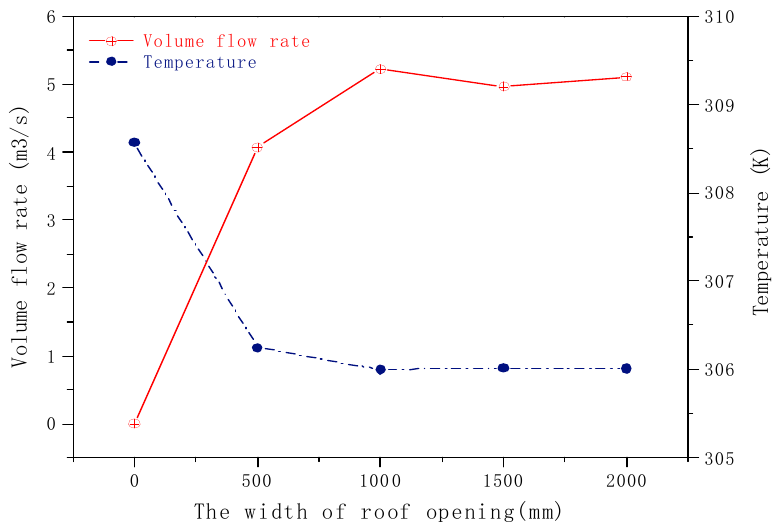
Figure 10. Volumetric flow and temperature values for different widths of roof opening.